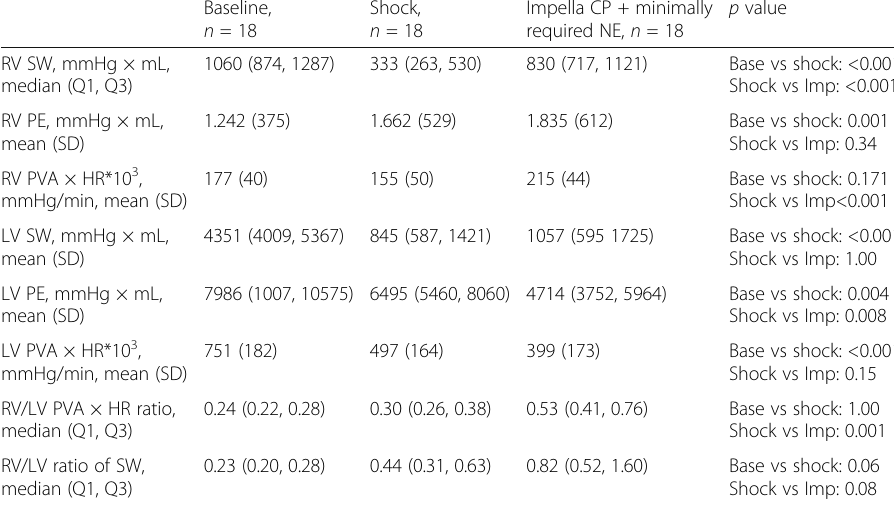
RV/LV PVA × HR ratio, median (Q1, Q3) RV/LV ratio of SW, median (Q1, Q3) NE norepinephrine, RV right ventricle, LV left ventricle, SW stroke work, PE potential energy, PVA pressure-volume area, HR heart